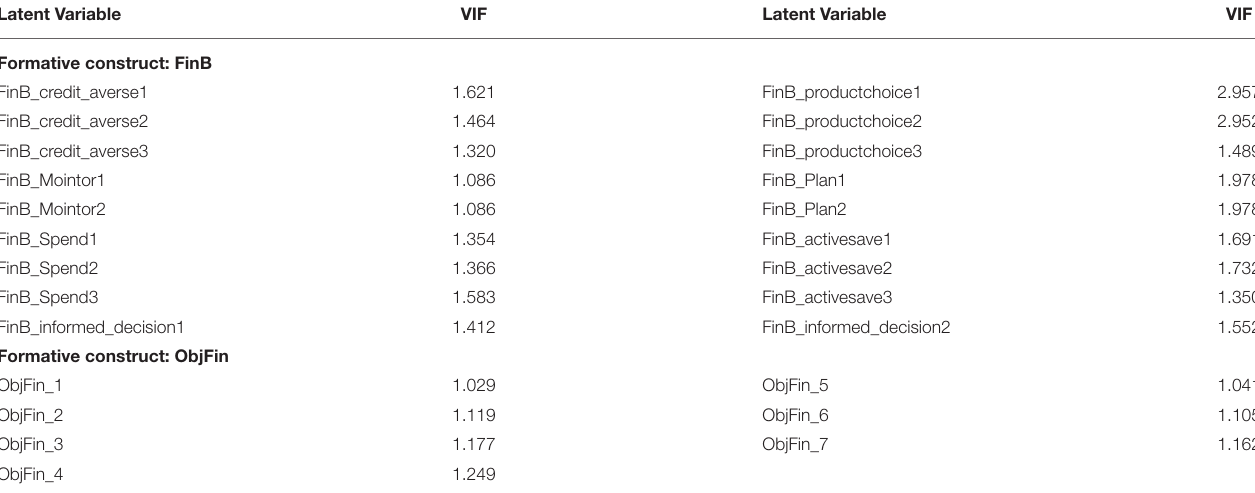
TABLE 4 | Collinearity assessment.